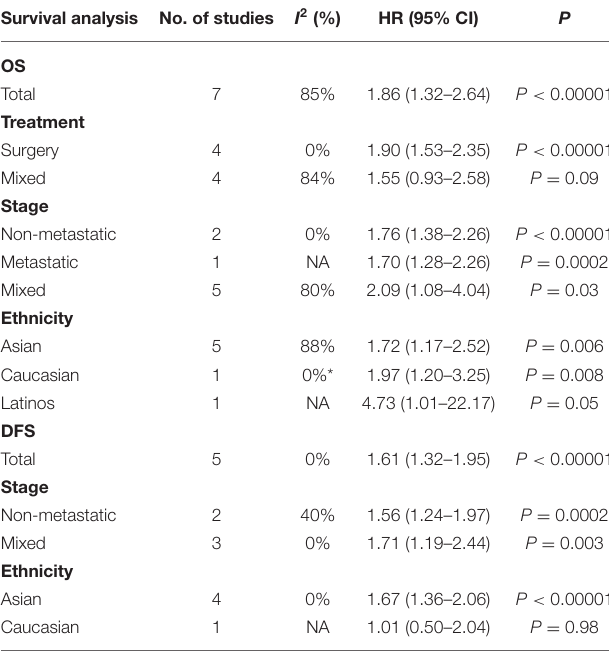
TABLE 3 | Subgroup analysis of the prognostic value of elevated CRP. Survival analysis No. of studies I 2 (%)